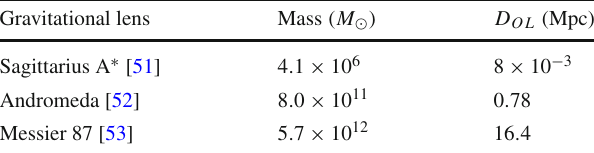
Fig. 6 The diagram of the gravitational lensing Table 2 The mass of the Sagittarius A ∗ SMBH and the Andromeda and Messier galaxies and the distance from them to the Earth Gravitational lens Mass ( M (cid:23)